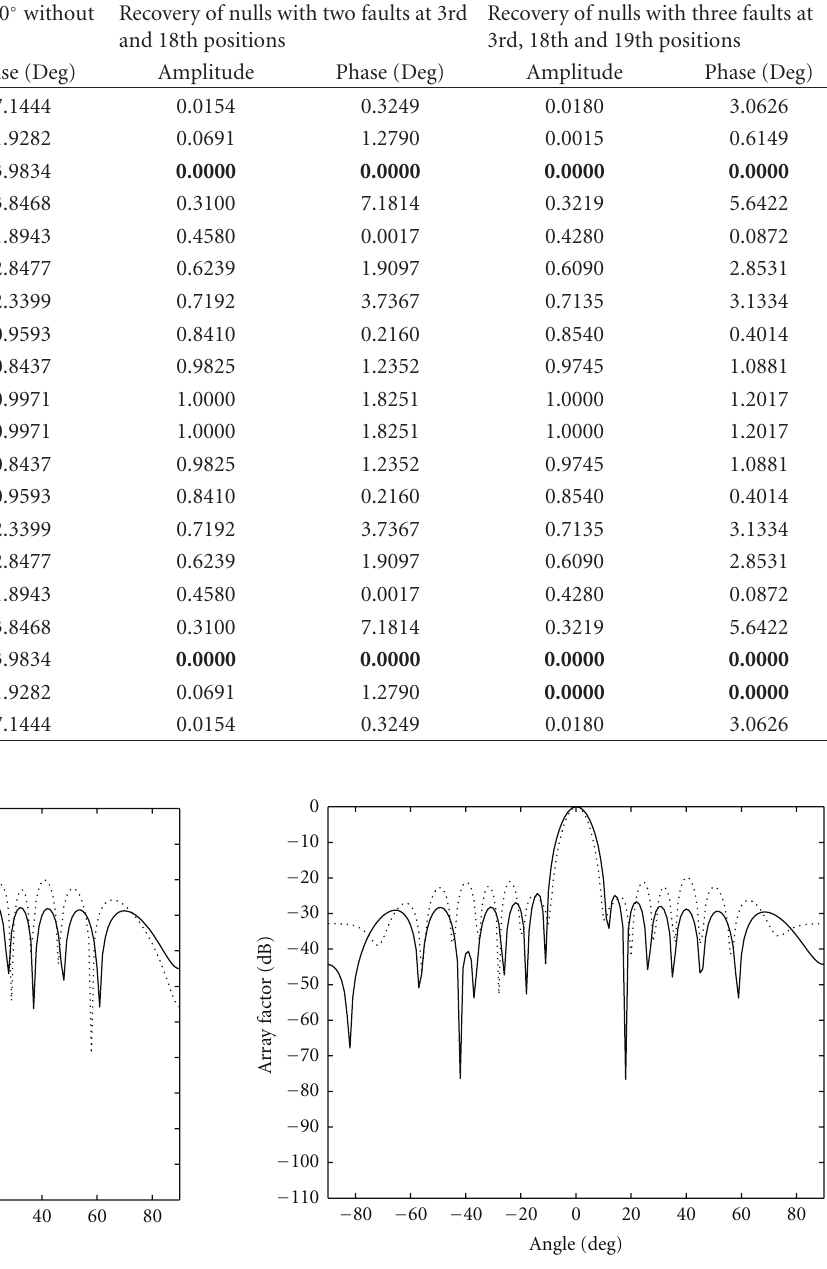
Figure 10: Radiation pattern for 3rd, 18th, and 19th element failure with main beam at broadside and nulls at − 42 ◦ and 18 ◦ . Dotted line curve shows the damaged array pattern and the solid line curve shows the corrected